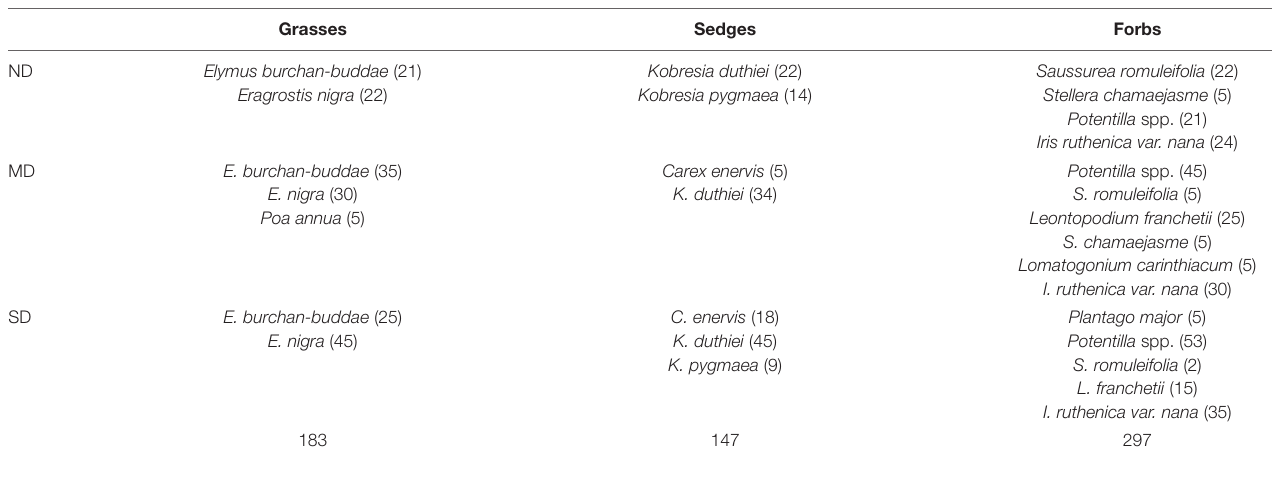
TABLE 2 | The species and number of plant individuals that were collected in no obvious degradation (ND), moderate degradation (MD), and severe degradation (SD)